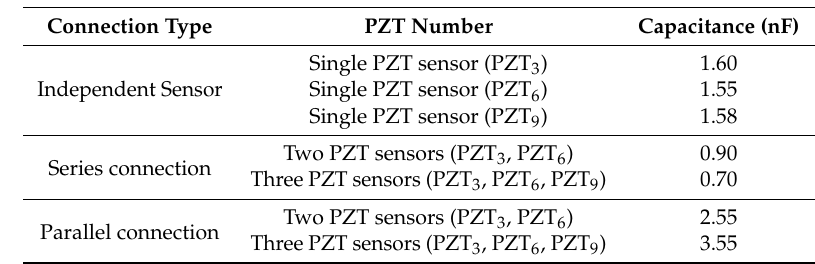
Table 1. Capacitance of PZT 3 , PZT 6 and PZT 9 in independent connection type, series connection type and parallel connection type.